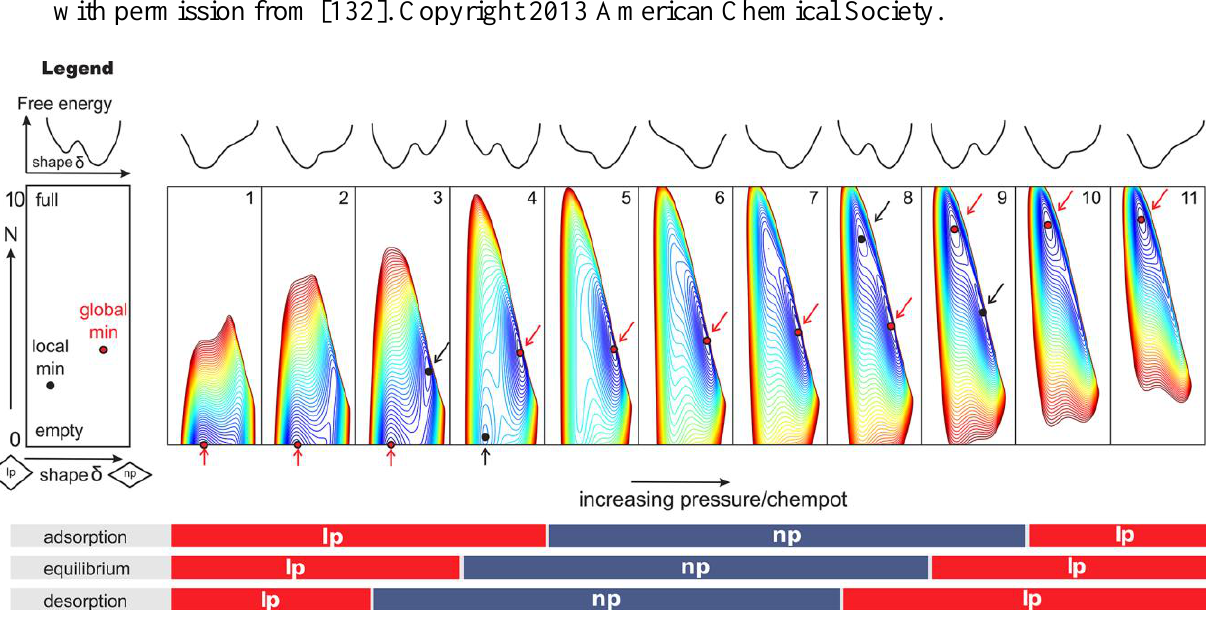
Figure 23. Free energy simulation of CO adsorption on MIL-53(Cr) at 300 K under 2 various pressure ranges. The blue-colored contour represents the lowest free energy, while the red-colored contour means the highest free energy. The under panel shows the expected framework structure during adsorption, equilibrium and desorption processes. Reprinted with permission from [132]. Copyright 2013 American Chemical Society.